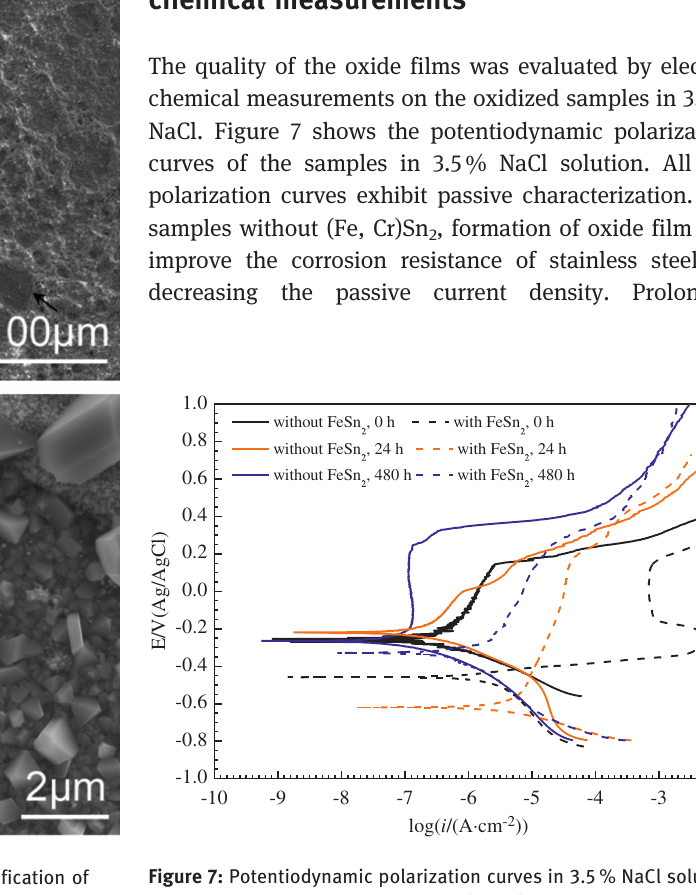
Figure 6: SEM morphologies and selected high magnification of oxide film on stainless steel with (Fe, Cr)Sn 2 adhesion after 240 h exposure to 300°C water.